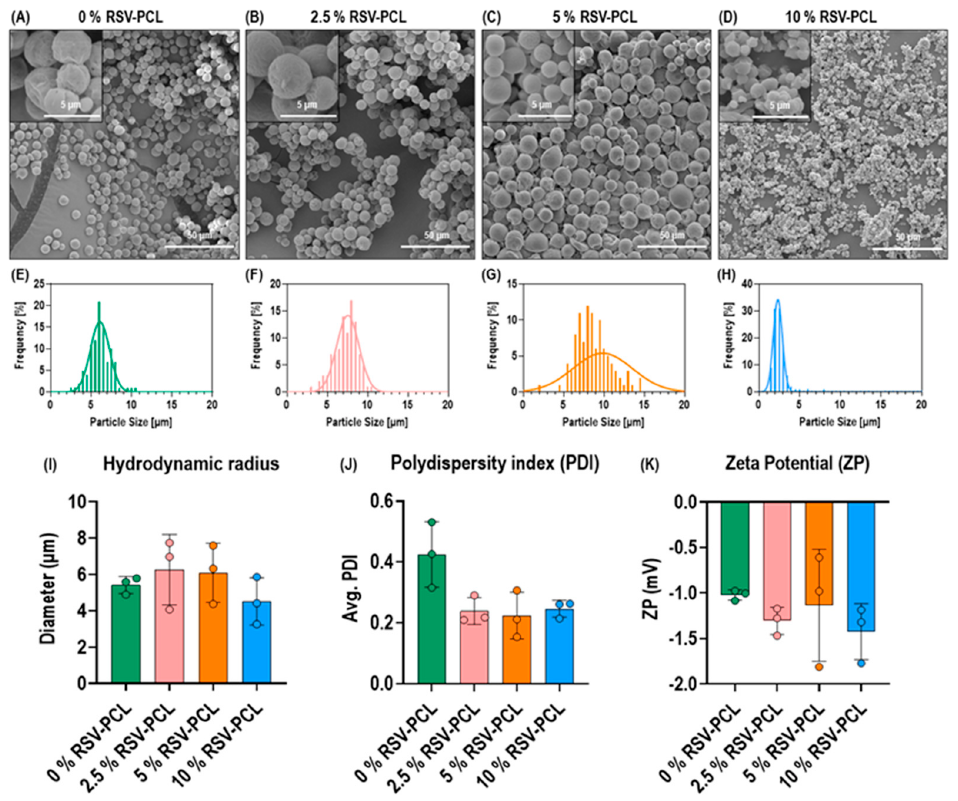
Figure 1. Morphological and dynamic light scattering (DLS) analyses of RSV-PCL electrosprayed microparticles. Scanning electron microscopy analysis of ( A ) 0% RSV-PCL, ( B ) 2.5% RSV-PCL, ( C ) 5% RSV-PCL, ( D ) 10% RSV-PCL revealed that all electrosprayed samples were composed of uniform (fiber-free) particles spherical in shape ( n = 3 batches). Particles size distribution analysis showed that ( E ) the 0% RSV-PCL, ( F ) 2.5% RSV-PCL, and ( G ) 5% RSV-PCL samples were comprised of particles with a diameter range from 5 µ m to 10 µ m, while ( H ) the 10% RSV-PCL samples were comprised of particles with a diameter range from 2 µ m to 4 µ m ( n = 3 batches). No significant ( p > 0.05) differences were observed in ( I ) hydrodynamic radii, ( J ) polydispersity indices, and ( K ) zeta potential between groups ( n = 3 batches). Individual values are displayed as dots on bar charts. Error bars represent mean ± SD. Generalized linear models and bootstrap- t